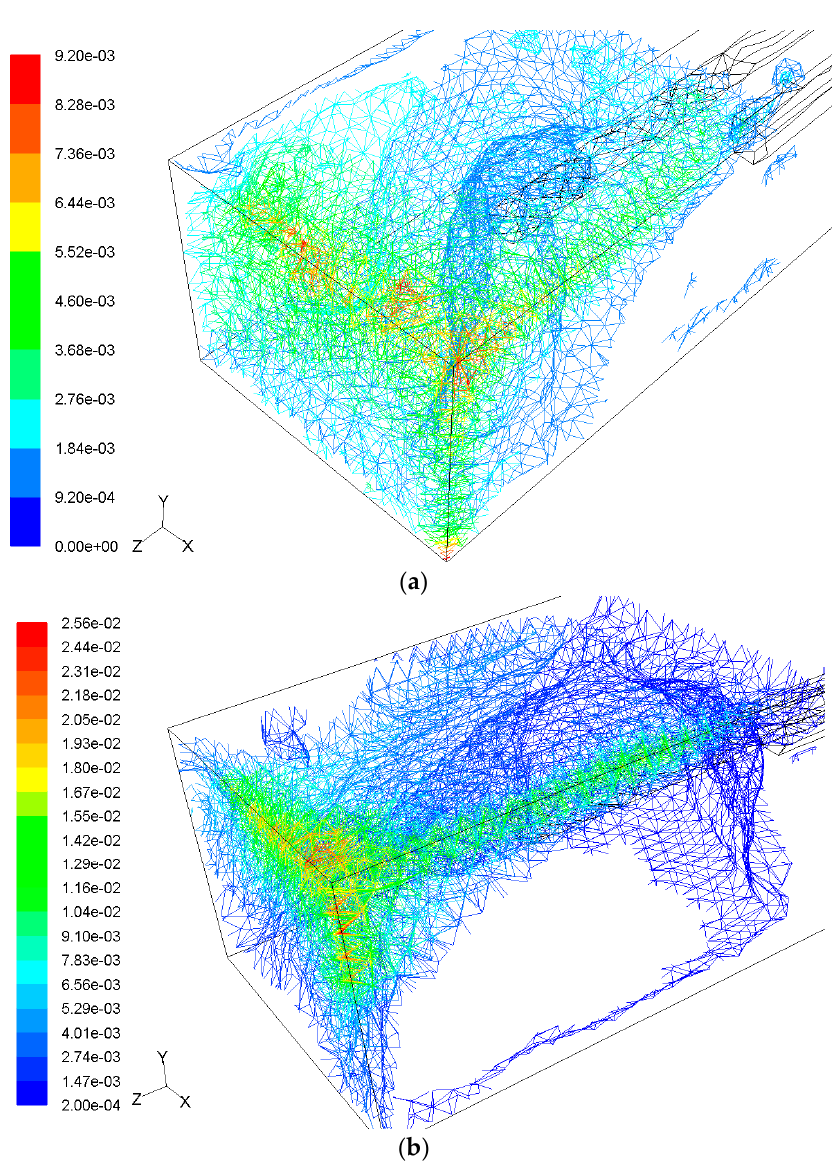
Figure 15. Coal dust concentration distribution near heading face under vortex ventilation system. ( a ) Total dust concentration distribution (kg/m 3 ); ( b ) respirable dust concentration distribution (kg/m 3 ).